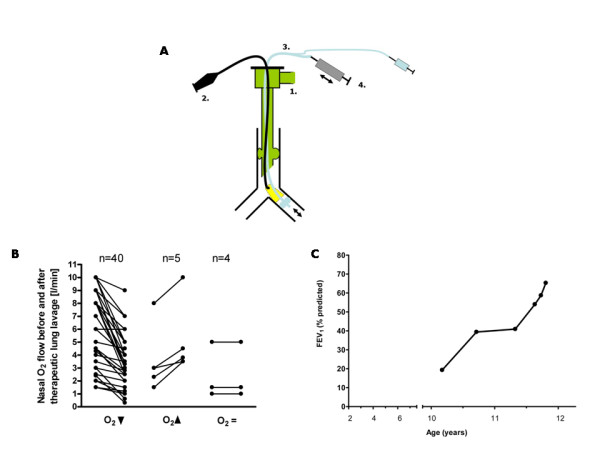
Whole lung lavages were performed, due to the small sizes of the airways until the age of 6 y, via a blocked endotracheal tube through which the child was ventilated (Figure. 3 A, 1.) and through which also a pulmonary artery catheter (Figure. 3 A, 3., blue) was inserted and blocked in the left or right main stem bronchus (small syringe) and the lavage was done (Figure. 3 A, 4., large syringe). The tight fit of the blocked pulmonary artery catheter was continuously monitored via a 1.8 mm endoscope (Figure. 3 A, 2., black). Figure. 3 B shows the change of nasal flow of oxygen before and after the first 49 whole lung lavages (P < 0.0001, paired comparison by Wilcoxon test); in the figure values are ordered according observed change in oxygen flow ("triangle tip down" indicates reduced flow after lavage, "triangle tip upwards" indicates increased flow of oxygen after lavage, and " = " indicates unchanged flow of oxygen. From year 10 onward lung function tests were performed, forced vital capacity (FVC) improved dramatically with more intensely performed lavages (not shown), as did forced expiratory volume in 1 second (FEV1) (Figure. 3 C).